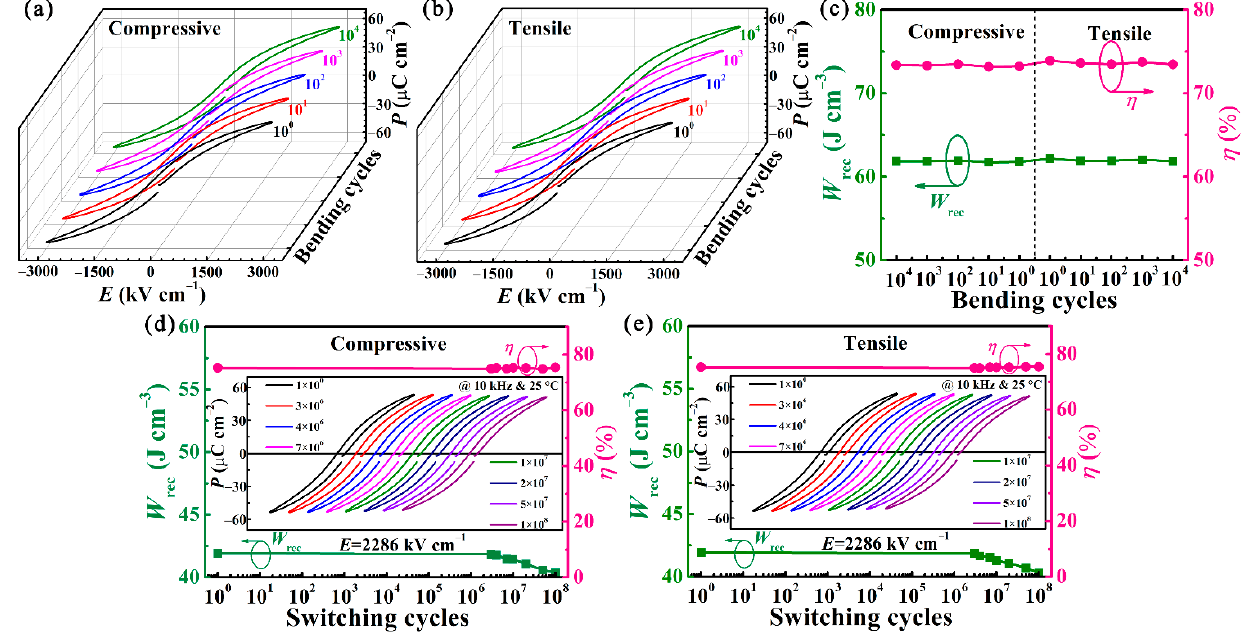
Figure 5. ( a , b ) P - E loops of BST/0.4BFO-0.6STO film under various bending cycles under the compressive and tensile states. ( c ) W rec and η as functions of bending number. ( d , e ) W rec and η as functions of switching cycle during 10 8 fatigue cycles under compressive and tensile bending states with r = 4 mm. The insets are the corresponding P-E loops. (The lines in figure 5a,b from black to green represent the measurements of the bending cycles of BST/0.4BFO-0.6STO film from 10 0 to 10 4 , respectively.)